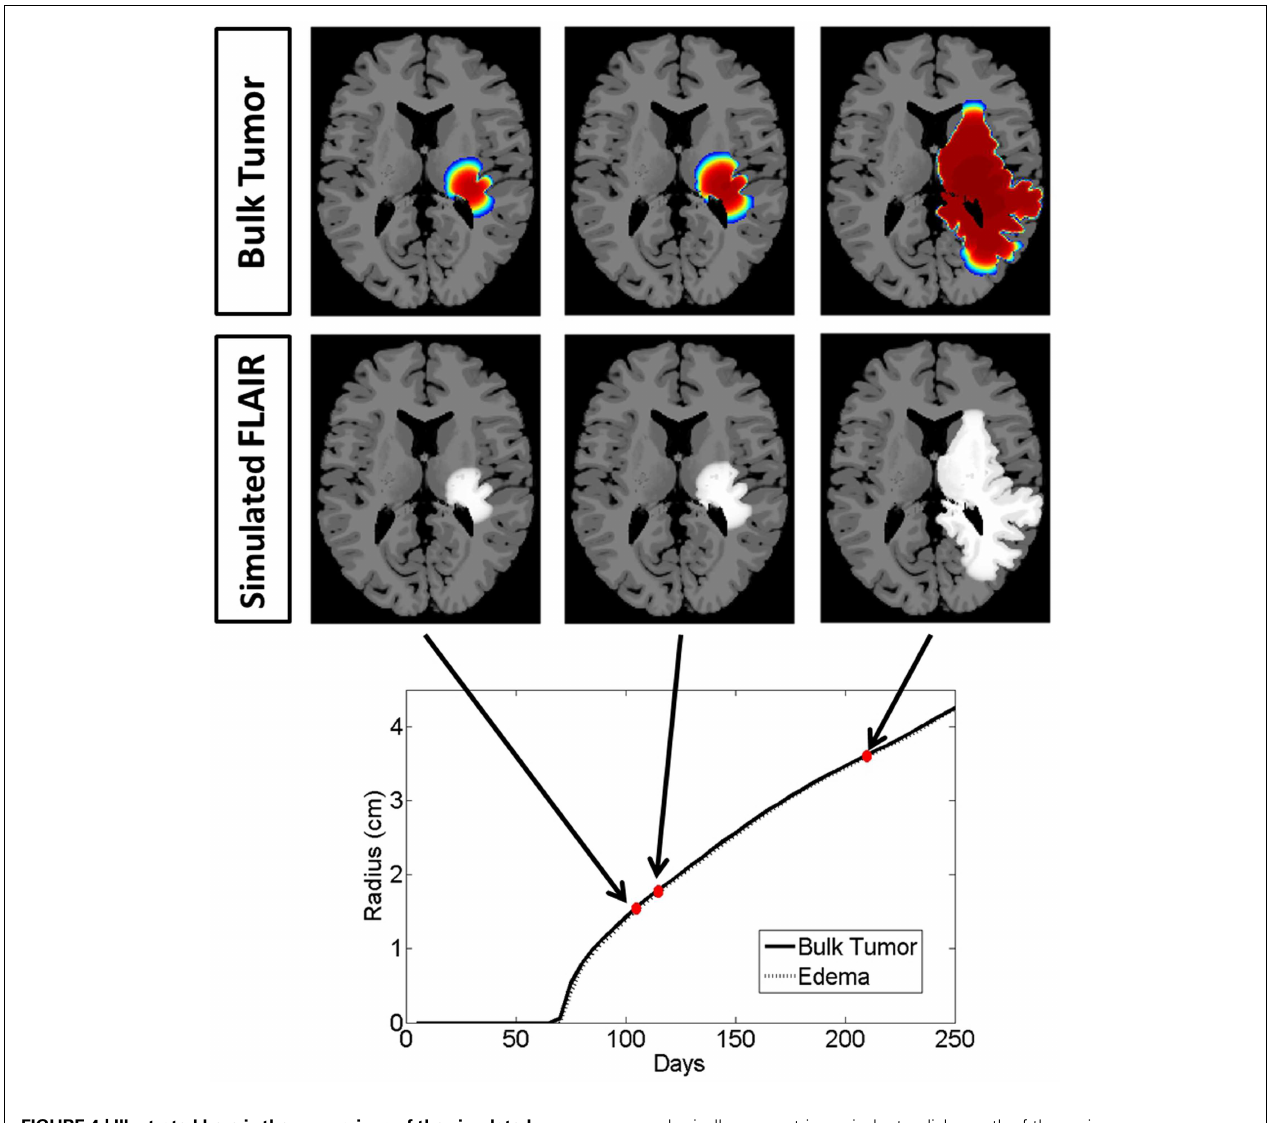
FIGURE 4 | Illustrated here is the comparison of the simulated disease burden to what would be imageable on a FLAIR MRI in an untreated context for one set of growth parameters corresponding to an aggressive GBM. Below the plot shows the